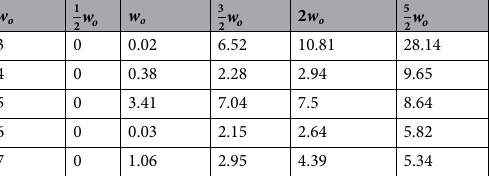
Table 4. Percentage of sampled cases displaying OEE (satisfying Definitions 1 and 2) for Case I, with varying environment size w